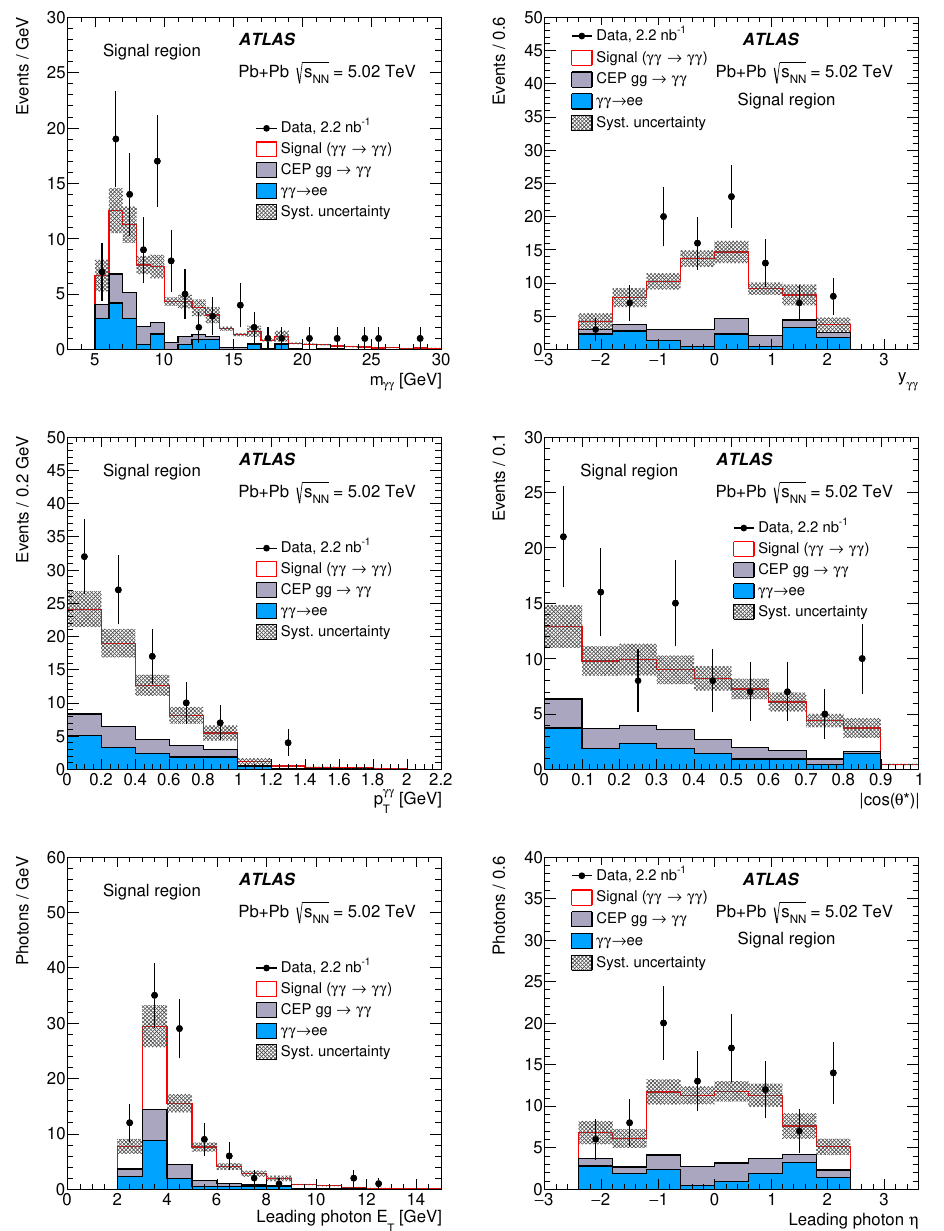
Figure 7 . Kinematic distributions for γγ → γγ event candidates: diphoton invariant mass (top- left), diphoton rapidity (top-right), diphoton transverse momentum (mid-left), diphoton | cos( θ ∗ ) | (mid-right), leading photon transverse energy (bottom-left) and leading photon pseudorapidity (bottom-right). Data (points) are compared with the sum of signal and background expectations (histograms). The signal prediction is normalised to the same integrated luminosity as the data. Systematic uncertainties in the signal and background processes, excluding that in the luminosity, are shown as shaded